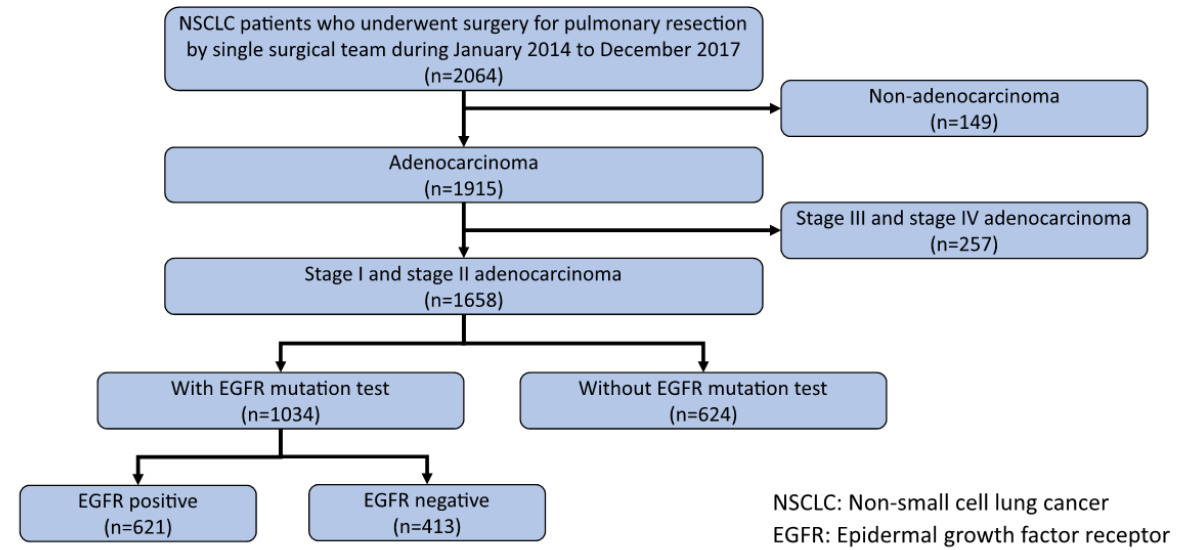
Figure 1. Flow chart of patient